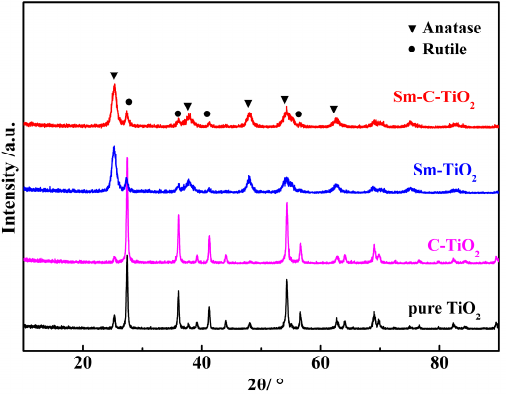
Figure 1. XRD patterns of the pure TiO 2 , C-TiO 2 , Sm-TiO 2 , and Sm-C-TiO 2 samples calcined at 500 °C. Table 1. XRD results of the different TiO 2 samples calcined at 500 °C.